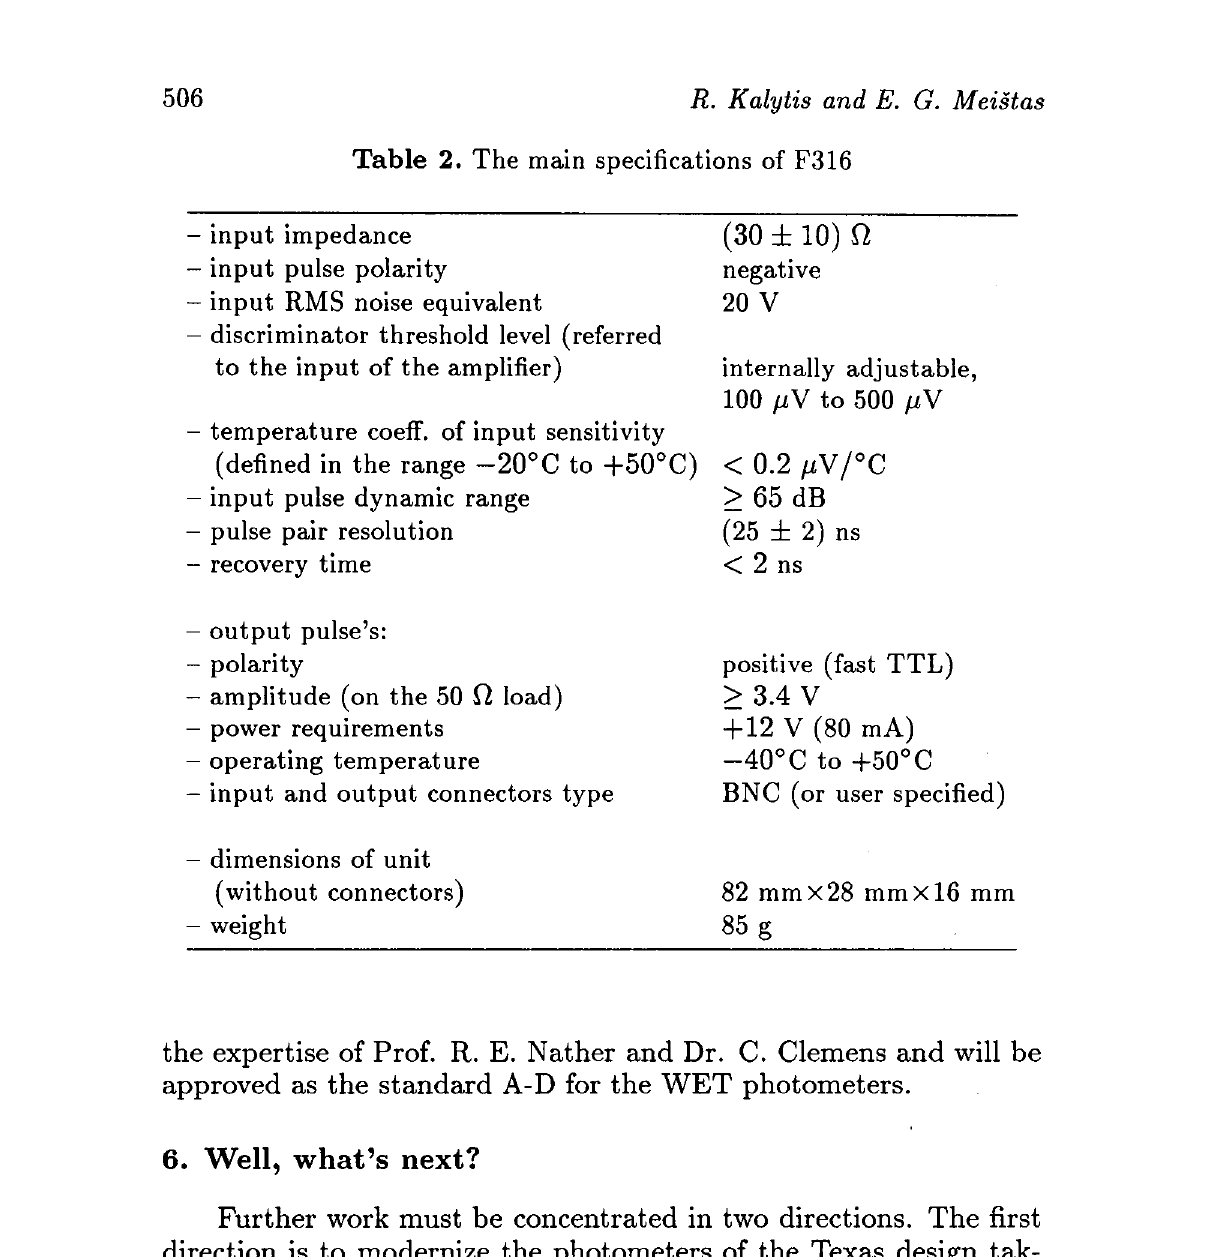
Table 2. The main specifications of